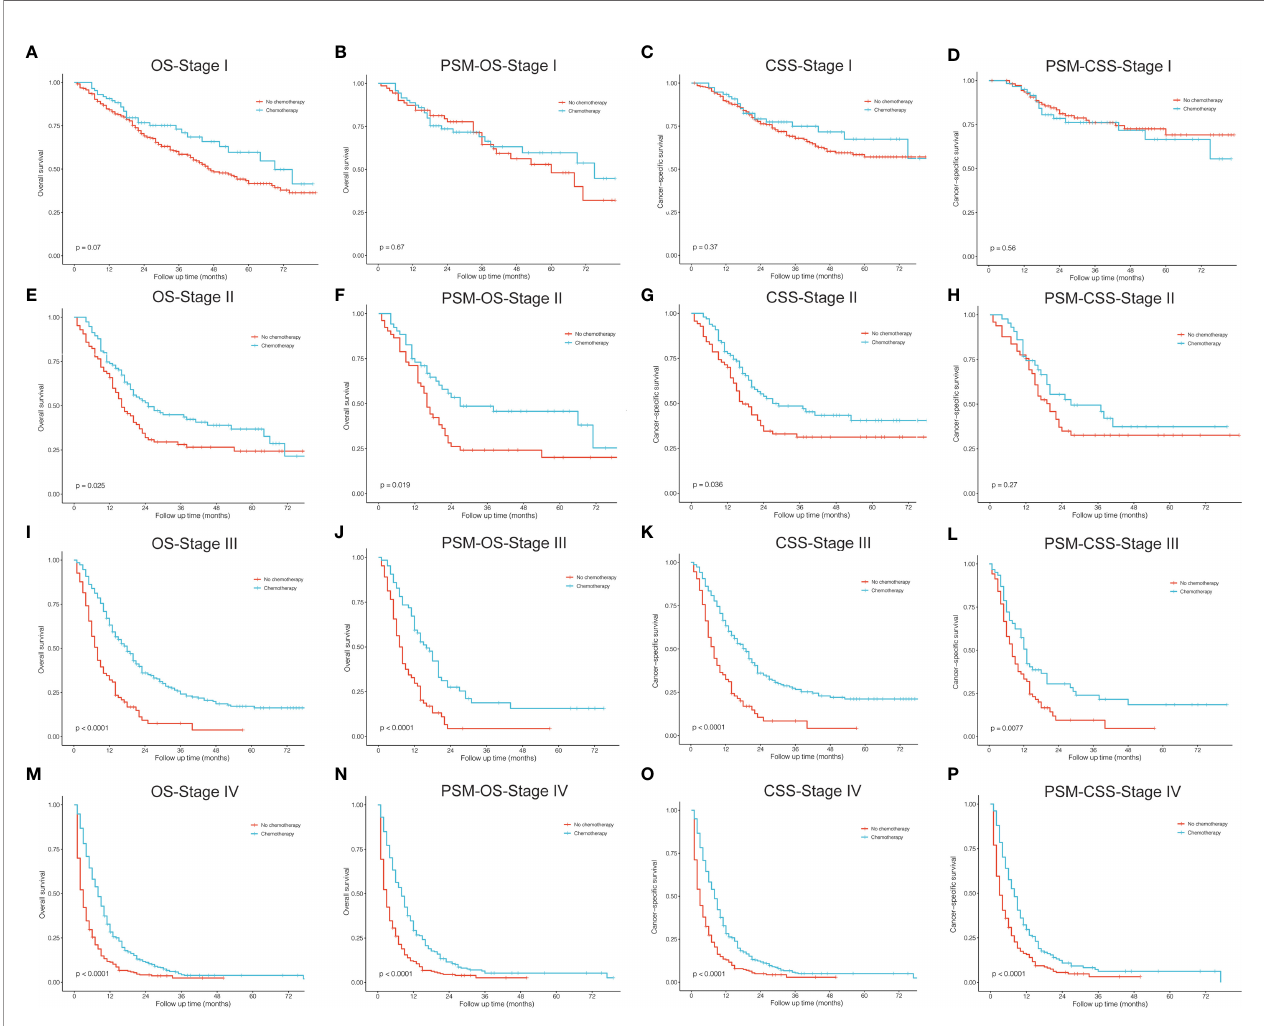
FIGURE 6 | Kaplan – Meier curves for comparisons of chemotherapy vs. no chemotherapy in patients with pulmonary large cell neuroendocrine carcinoma. (A – D) Stage I; (E – H) Stage II; (I – L) Stage III; (M – P) Stage IV. OS, overall survival; CSS, cancer-speci fi c survival; PSM, propensity score